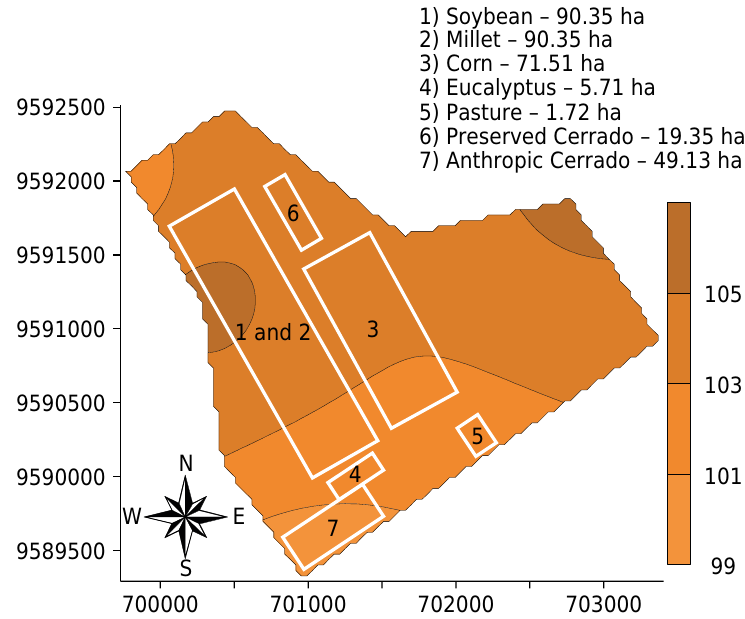
Figure 1. Location of study areas. 1 and 2 = soybean and millet; 3 = corn; 4 = eucalyptus; 5 = pasture; 6 = preserved Cerrado; and 7 = disturbed